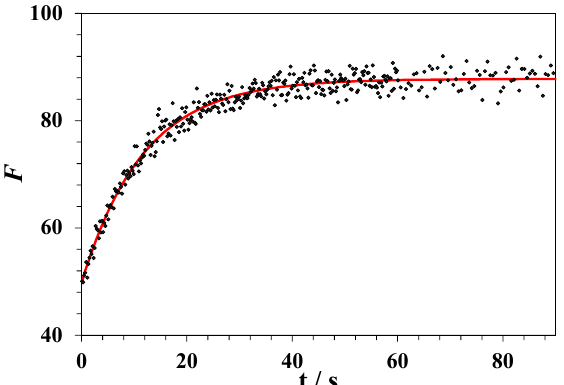
Figure 8. Changes in the fluorescence intensity upon unfolding of lysozyme in the DMSO–water mixture with a DMSO mole fraction of x 1 = 0.25 at a constant temperature 327 K. The red line corresponds to an exponential approximation via Equation (5).